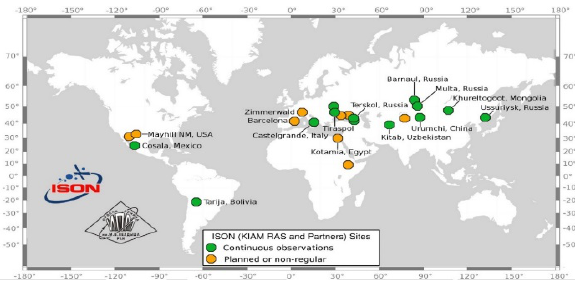
Figure 1. The geographic map of main KIAM/ISON facilities